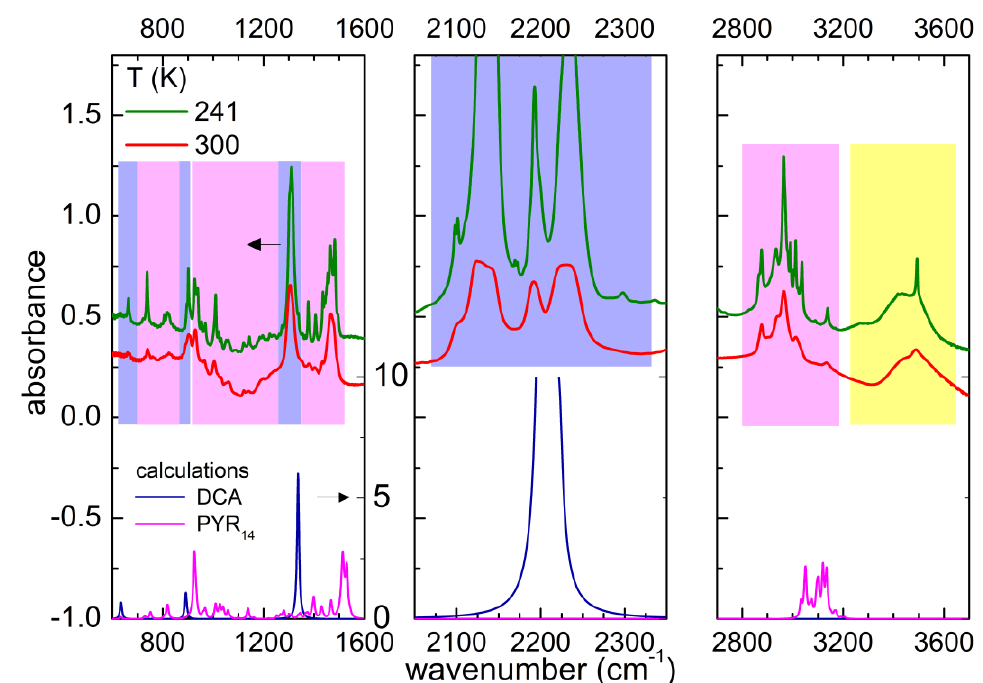
Figure 2. Comparison of the infrared absorbance of PYR 14 -DCA measured at 300 and 241 K on heating (upper part of the panels, the lines are vertically shifted for clarity) and the calculated absorbance for the isolated ions DCA and PYR 14 (lower part of the figures). For dicyanamide a scaling factor of the vibration frequencies of 0.97 was considered. The blue, magenta and yellow rectangles show the regions of the vibrations of the DCA anion, the PYR 14 cation and water, respectively. The scales of the vertical axes are the same in the three panels (as indicated in the left panel).